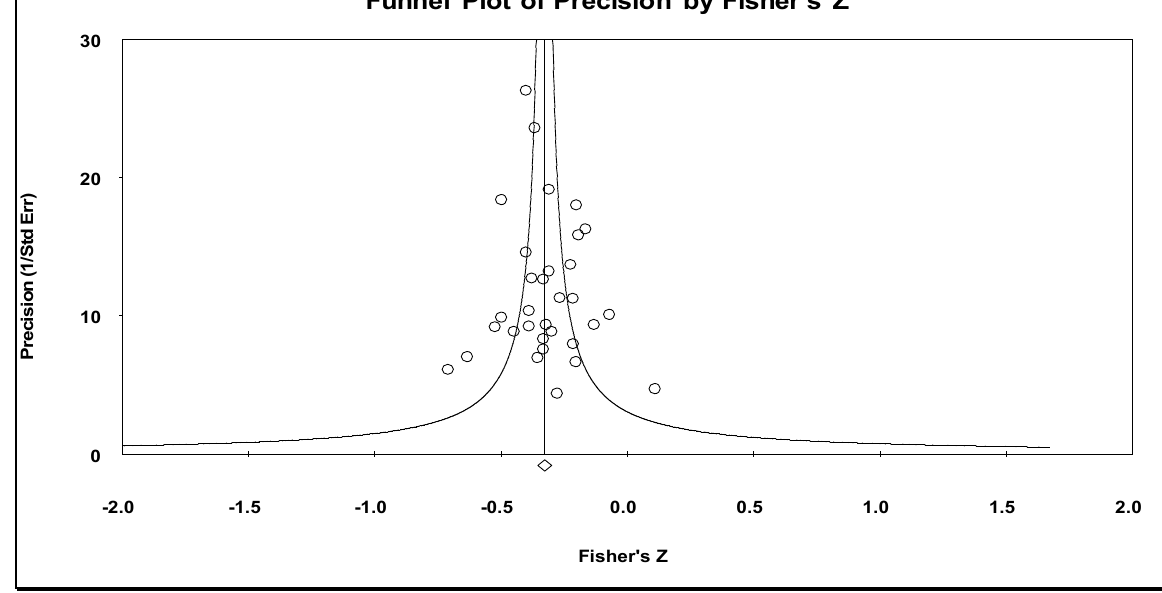
Figure 3. Funnel plot for perceived social support and anxiety symptoms in informal carers.